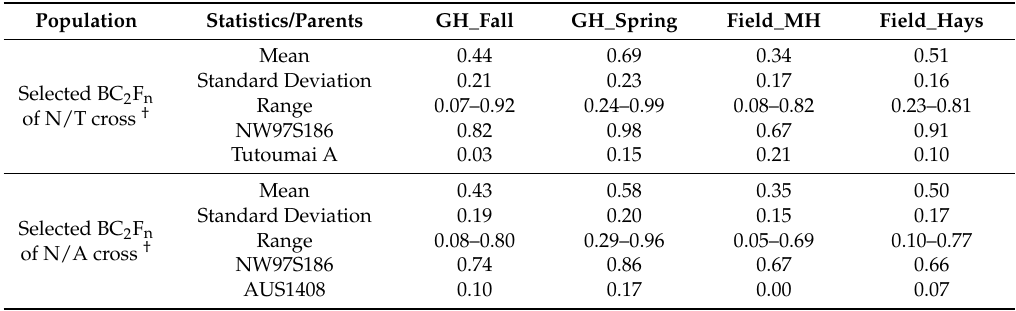
Table 1. Summary of germination rates of NW97S186, Tutoumai A, AUS1408 and their selected backcross progenies in the 2015 fall and 2016 spring greenhouse experiments (GH_Fall and GH_Spring) and in the 2016 Manhattan and Hays, KS, field experiments.